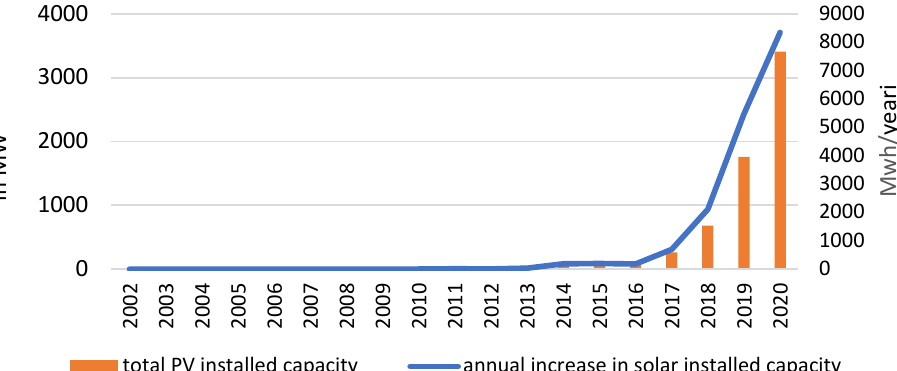
Figure 2. Total PV installed capacity and the annual increase in solar installed capacity in Poland [38].